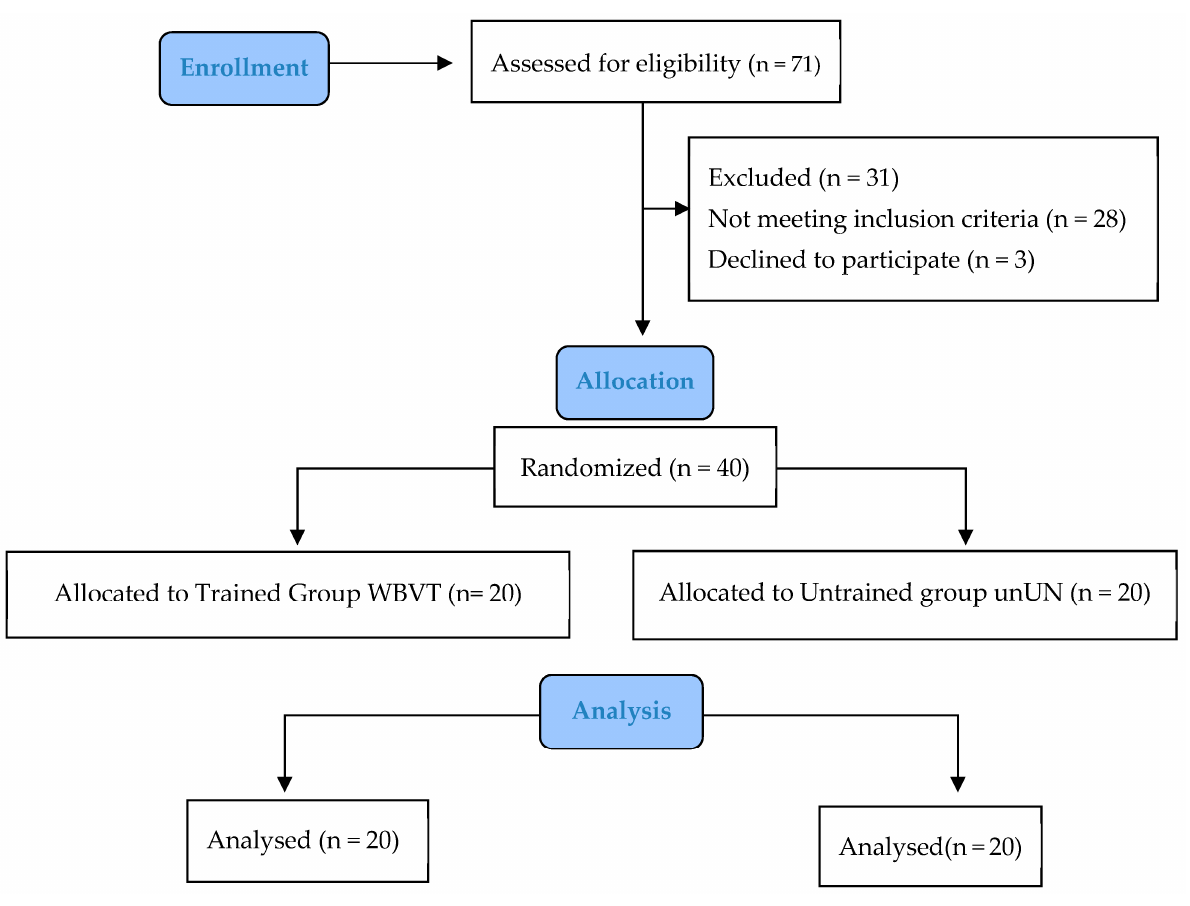
Figure 1. Study flowchart showing recruitment and final analysis of participants.